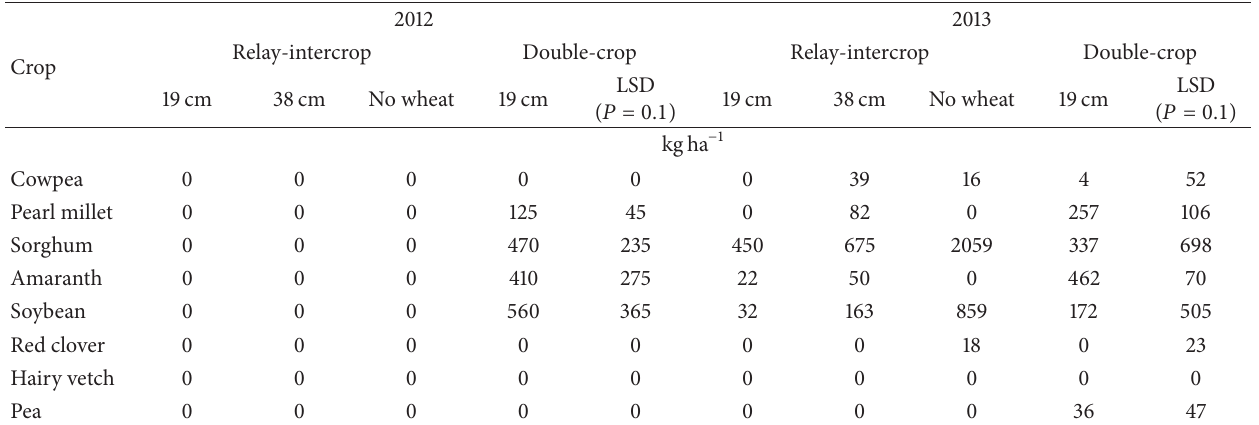
Table 5: Alternative crop grain yields for wheat row spacing in 2012 and